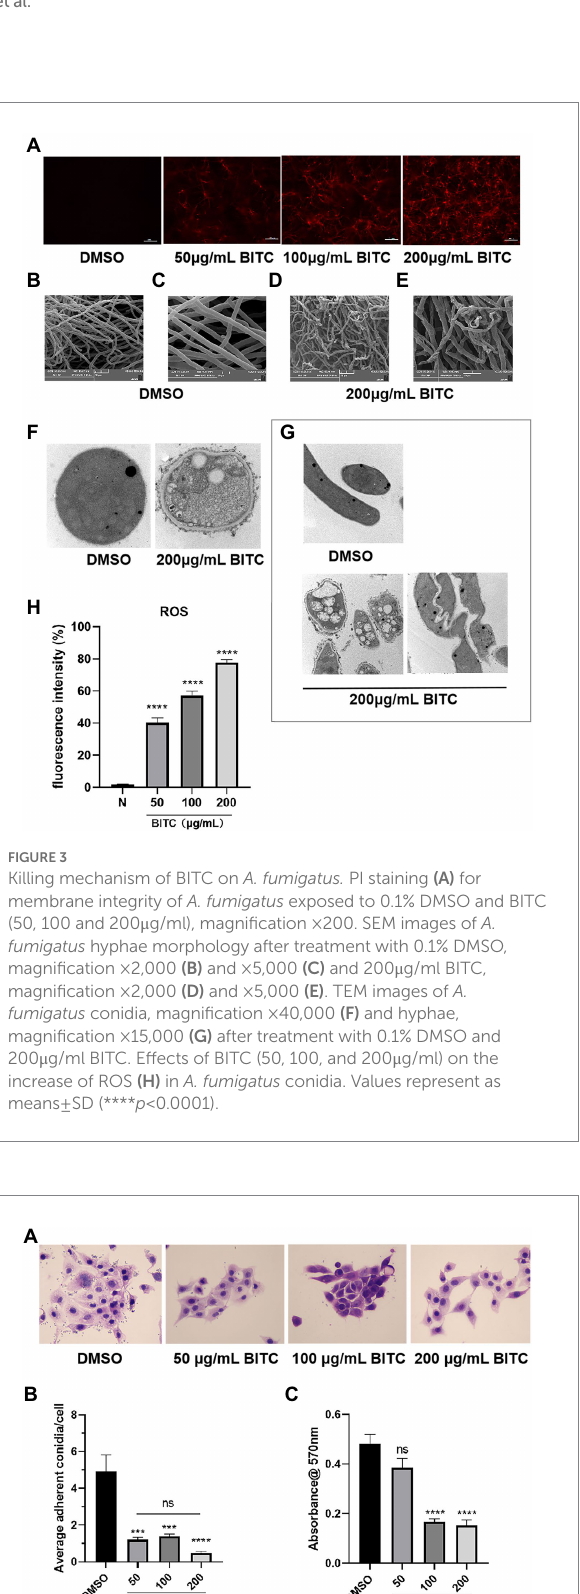
FIGURE 4 BITC inhibited A. fumigatus conidia adhesion and biofilm. HE staining images (A) of adherent A. fumigatus conidia to HCECs after 0.1% DMSO and BITC (50, 100 and 200 μ g/ml) treatment (magnification ×400), and the quantitative diagram is shown (B) . The inhibition of biofilms (C) under the treatment of BITC (50, 100 and 200 μ g/ml) and 0.1% DMSO. Values represent as means ± SD (*** p < 0.001, **** p <